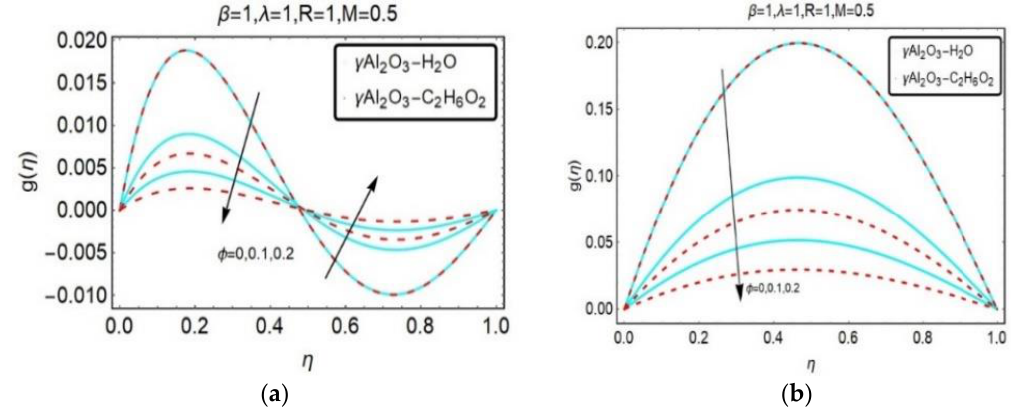
Figure 15. Influence of 𝜙 on 𝑔(𝜂) for ( a ) 𝑆 > 0 and ( b ) 𝑆 < 0 .